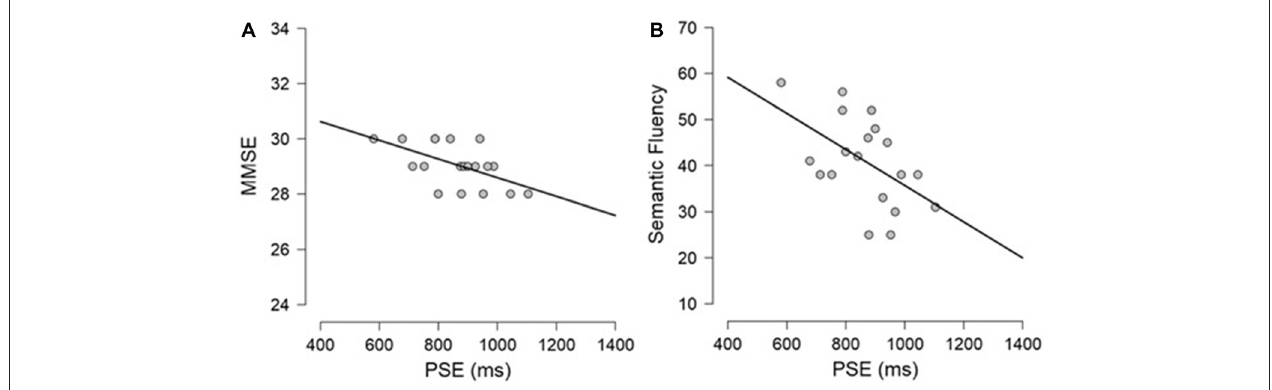
FIGURE 6 | Graphical representation of the Pearson’s correlational analyses conducted between (A) PSE and Mini-Mental State Examination (MMSE) and (B) PSE and Semantic fluency in the control group.